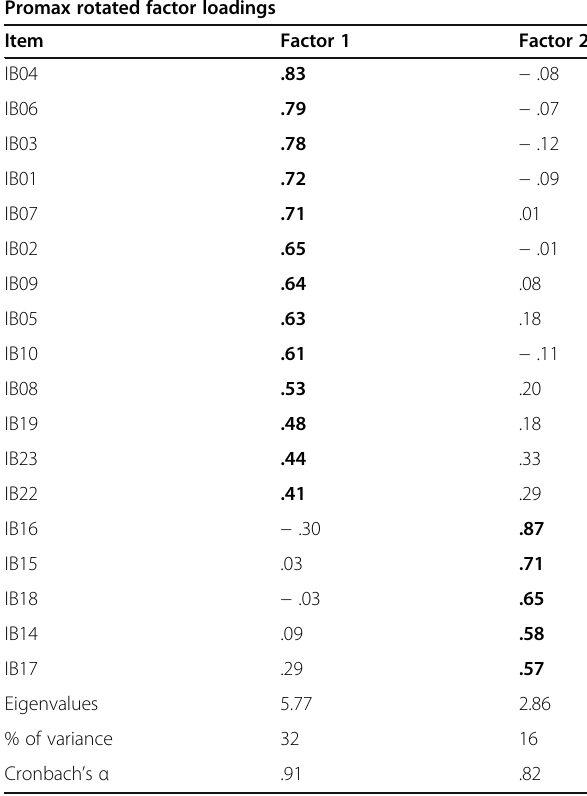
Table 3 Rotated component matrix of Thai RIBS version Promax rotated factor